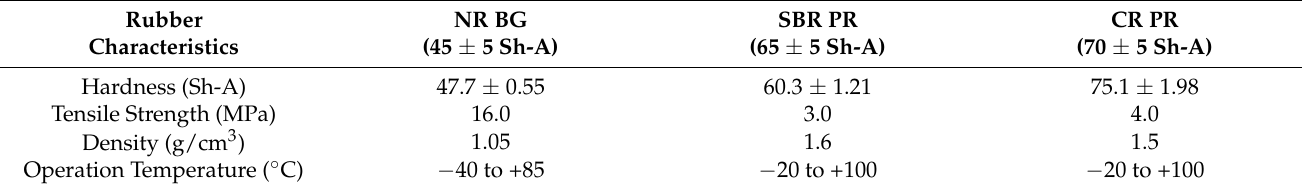
Table 3. Rubber plates characterization results.